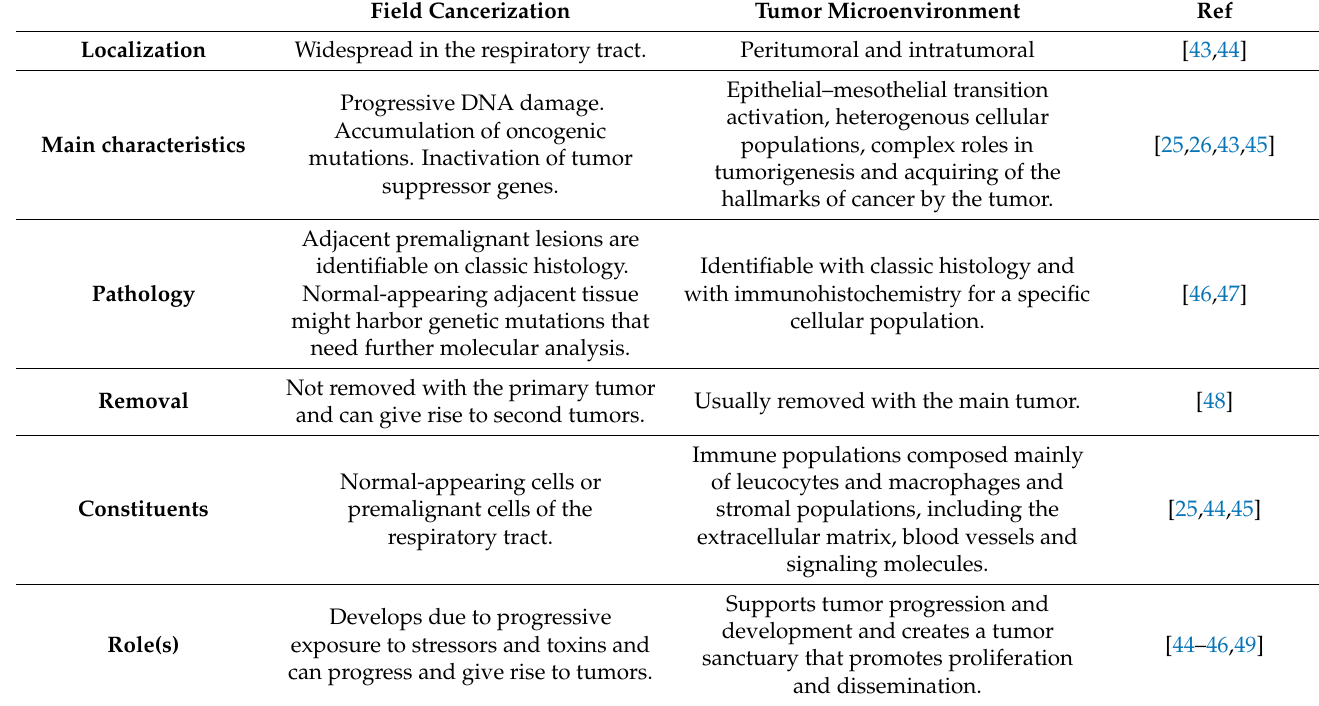
Table 1. Lung cancer field cancerization and tumor microenvironment comparative